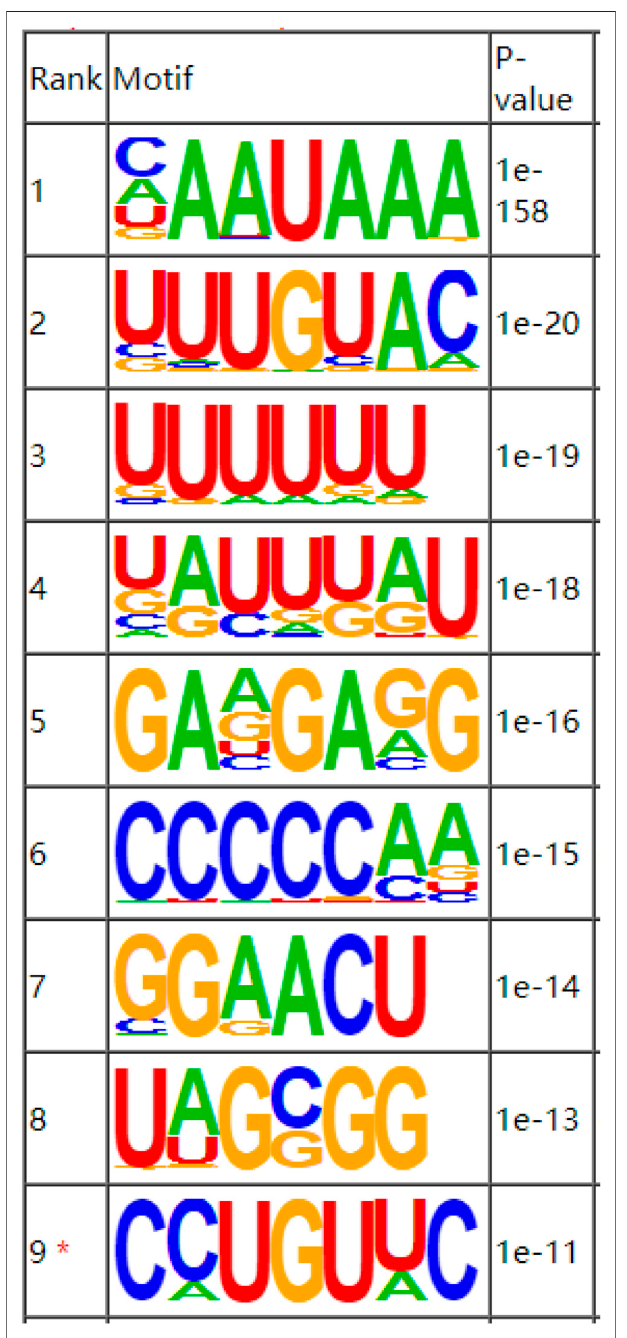
FIGURE 3 | Sequence showing the motifs with signi fi cant differences in muscle samples at the m6A peak.